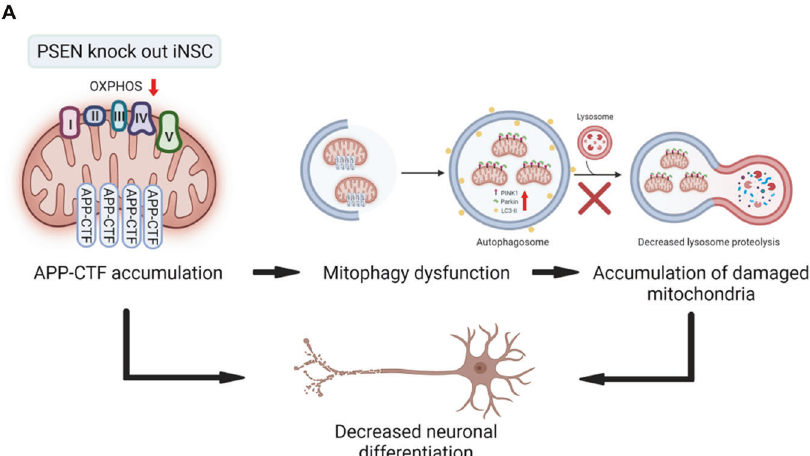
Fig. 7 Summary fi gure. A APP-CTFs are involved in the AD-related pathologies including mitochondria dysfunction, mitophagy failure, and neuronal